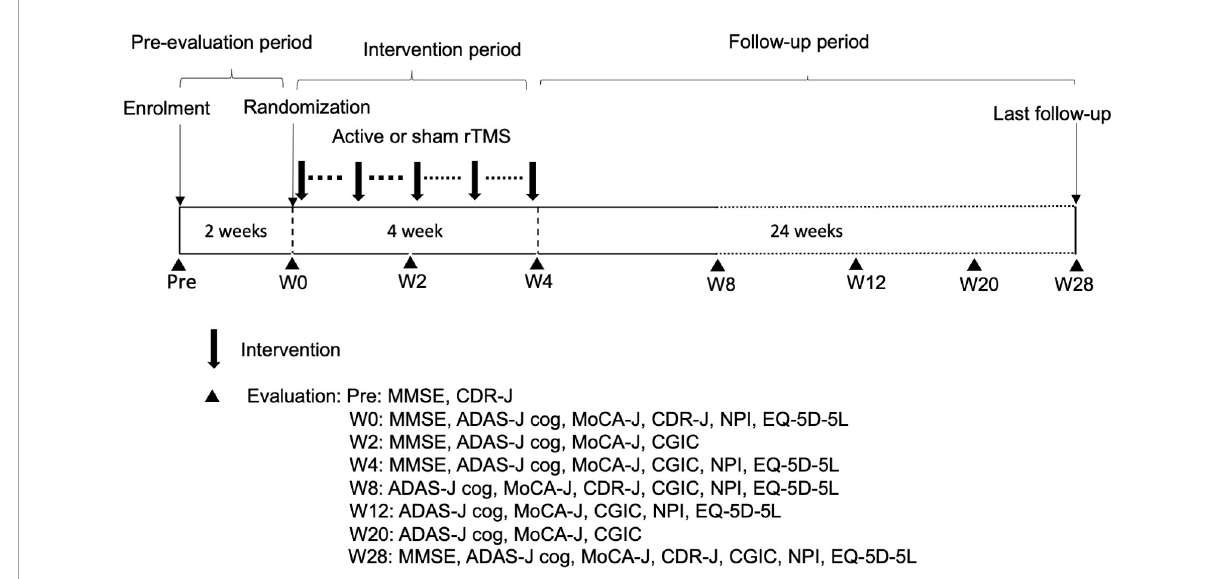
FIGURE1 Trial schedule. W, week; rTMS, repetitive transcranial magnetic stimulation; MMSE, Mini-Mental State Examination; CDR-J, Clinical Dementia Rating scale; ADAS-J cog, Alzheimer’s Disease Assessment Scale-Japanese Cognitive; MoCA-J, Montreal Cognitive Assessment; CGIC, Clinical Global Impression of Change; NPI, Neuropsychiatric Inventory; EQ-5D-5L, EuroQOL 5 dimensions